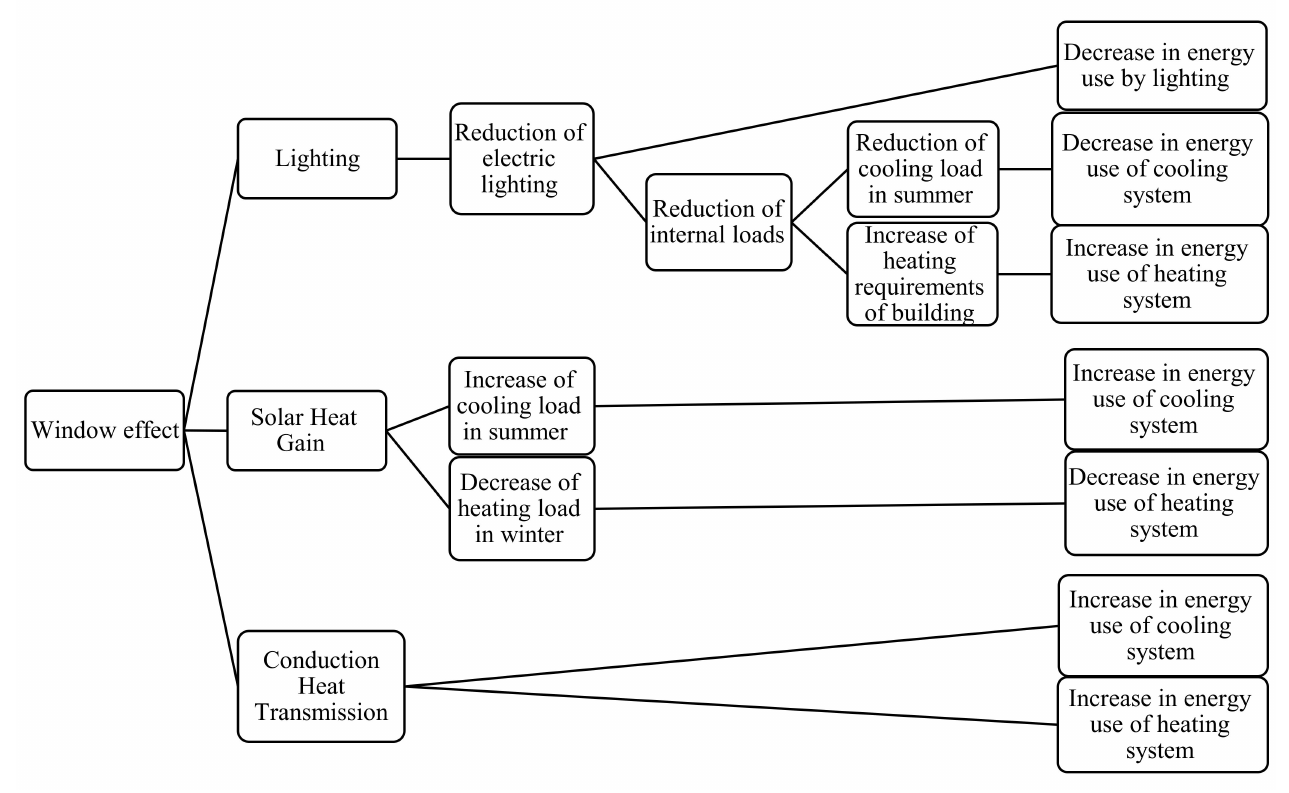
Figure 1. Effects of windows on the energy use of a